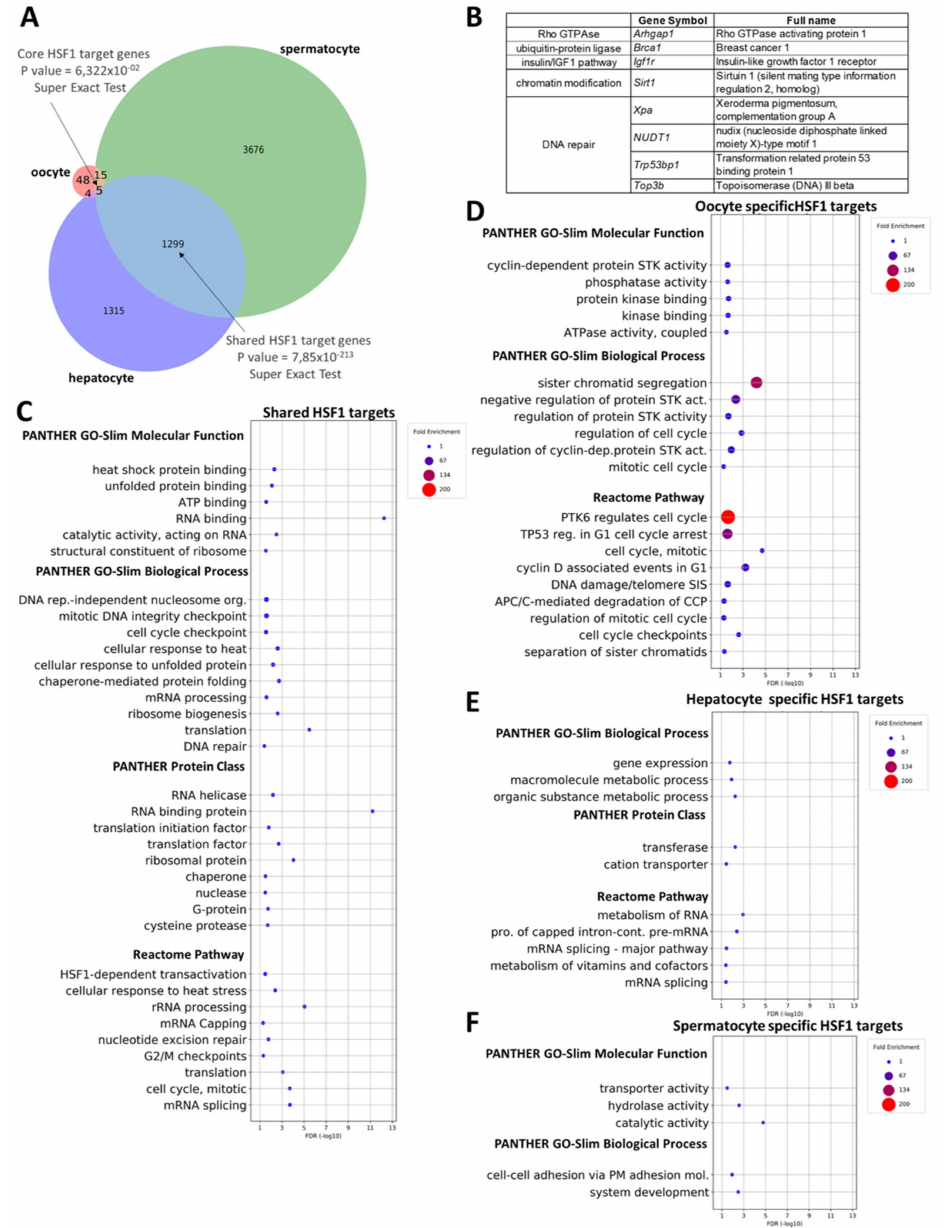
Figure 3. HSF1 binds tissue-specific and shared targets in mouse. ( A ) Venn-diagram representing overlaps between HSF1 target genes in all cell types analyzed. Overlaps between two datasets (blue and grey) are statistically significant ( p = 6.322 × 10 − 2 and p = 7.85 × 10 − 213 , super exact test; 20,993 unique mouse genes were used as a background); ( B ) HSF1 targets involved in ageing are shared between the three cell types; ( C ) PANTHER GO-Slim Molecular Function, PANTHER GO-Slim Biological Process, PANTHER Protein Class and Reactome Pathway analysis of the 1318 HSF1 target genes shared between at least two cell types; ( D ) PANTHER GO-Slim Molecular Function, PANTHER GO-Slim Biological Process and Reactome Pathway analysis of the 48, oocyte-specific HSF1 target genes; ( E ) PANTHER GO-Slim Biological Process, PANTHER Protein Class and Reactome Pathway analysis of 1315 hepatocyte-specific HSF1 target genes; ( F ) PANTHER GO-Slim Molecular Function and PANTHER GO-Slim Biological Process analysis of 3676 spermatocyte-specific HSF1 target genes. Filled circles depict statistically significant enrichment; X axis shows -LOG10 ( p -value) p < 0.05; Fisher’s exact test with Benjamini–Hochberg false discovery rate correction